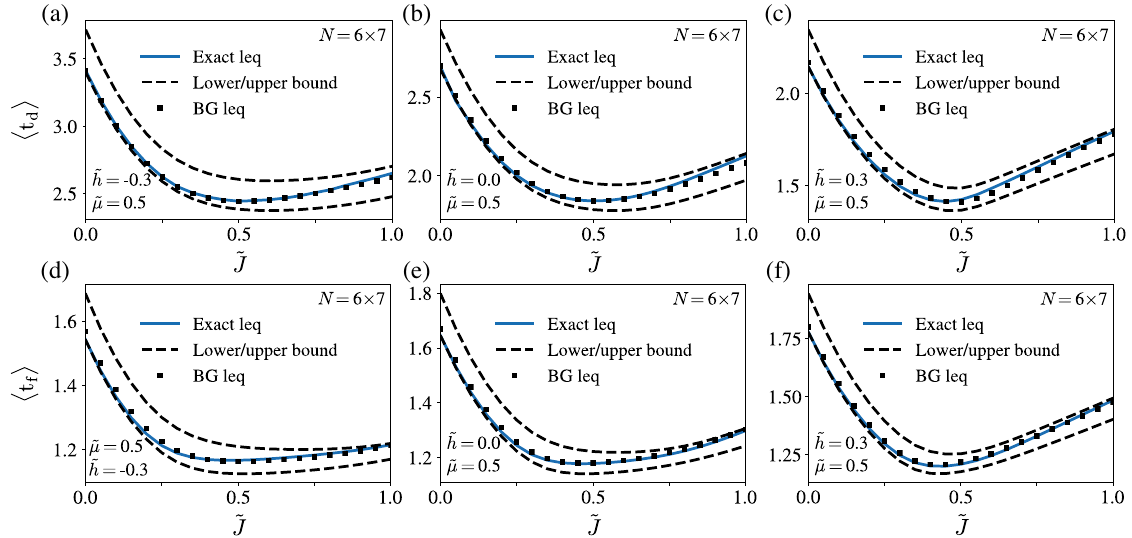
FIG. 16. Comparison of the exact local equilibrium effective rates and the approximate Bethe-Guggenheim local equilibrium effective rates for pure Glauber dynamics. We show h t for (a) – (c) cluster dissolution and (d) – (f) cluster formation as a function of the coupling d ; f i ˜ ˜ ˜ J h ¼ − 0 . 3 (a,d), zero force h ¼ 0 (b,e), and a pulling force for fixed intrinsic binding affinity ˜ μ ¼ 0 . 5 in the presence of a pushing force ˜ h ¼ 0 . 3 (c, f). The blue solid line is obtained with the exact local equilibrium effective transition rate and exact partition function Q k 1 ∀ k . The black symbols are obtained with the Bethe-Guggenheim approximation to the [Eqs. (21) and (6), respectively] with p k ¼ [Eqs. (21) and (6) in combination with Eq. (8), respectively]. The black dotted line indicates the effective rate and partition function Q BG k upper and lower bounds to the mean dissolution or formation time, which is obtained with the upper and lower bounds to the effective transition rate in combination with the exact partition function [Eqs. (E17) and (6),